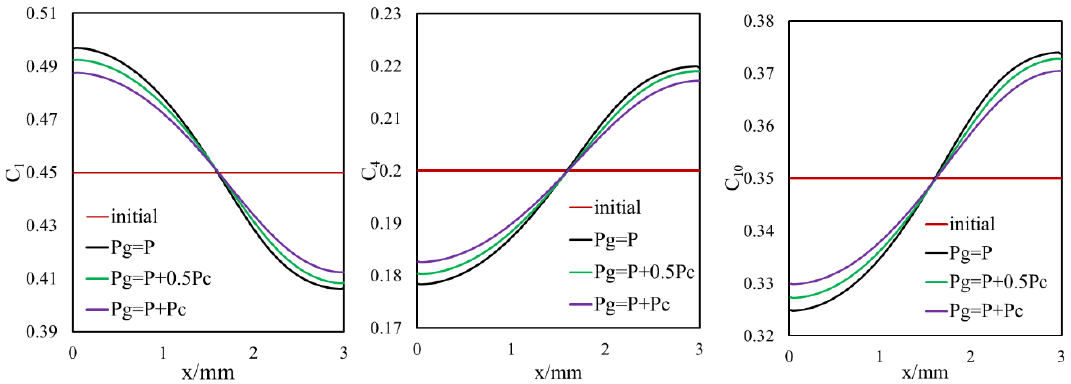
Figure 12. The overall composition of C 1 (left), C 4 (middle), C 10 (right) with different reference pressures, ternary mixture, with capillary pressure (Pc) in flow, without diffusion.